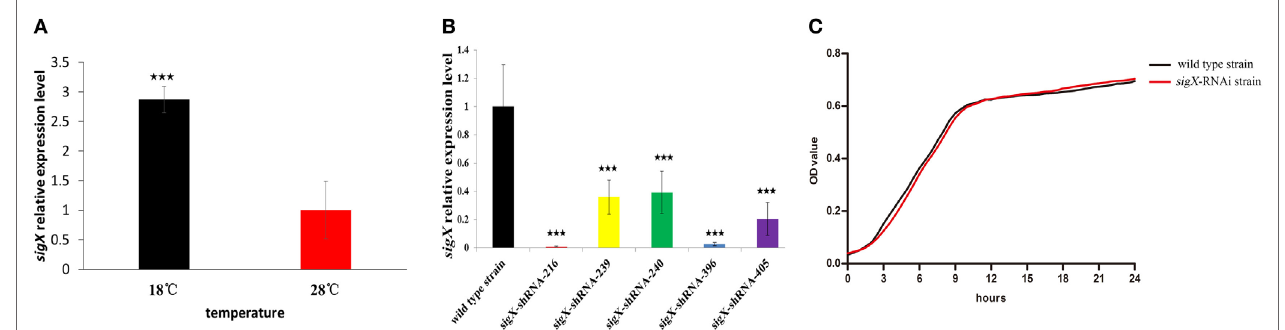
FigUre 1 | Construction and growth curve of sigX -RNAi strain of Pseudomonas plecoglossicida . (a) Expression of sigX mRNA at 28 and 18°C in wild-type strain. (B) The sigX mRNA levels of 5 sigX -RNAi silencing strain. (c) Growth curve of wild-type strain and sigX -RNAi strain. ★★★ P ≤